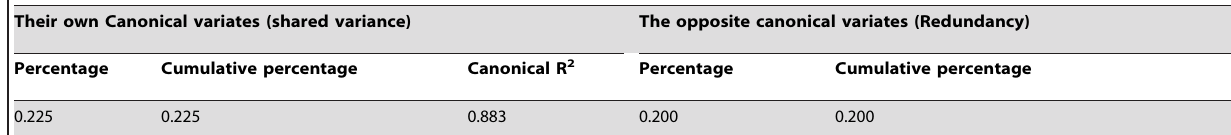
Standardized variance of the independent variables explained by Their own Canonical variates (shared variance) The opposite canonical variates